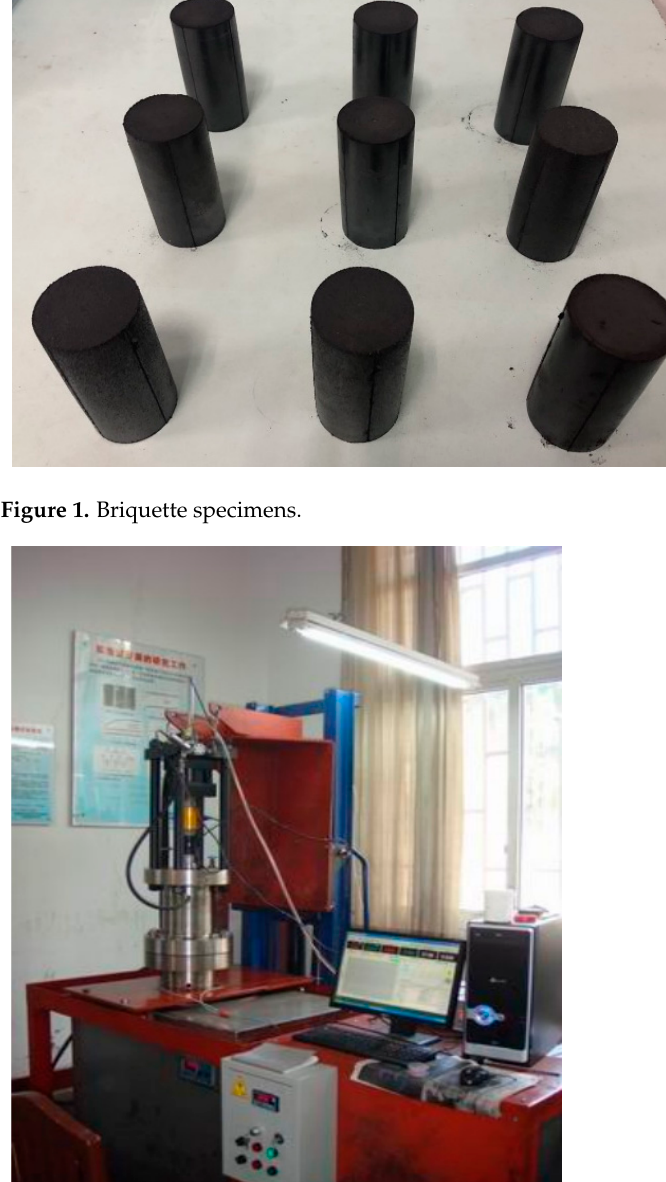
Figure 2. The triaxial servo-controlled seepage equipment for thermofluid–solid coupling of coal containing methane.